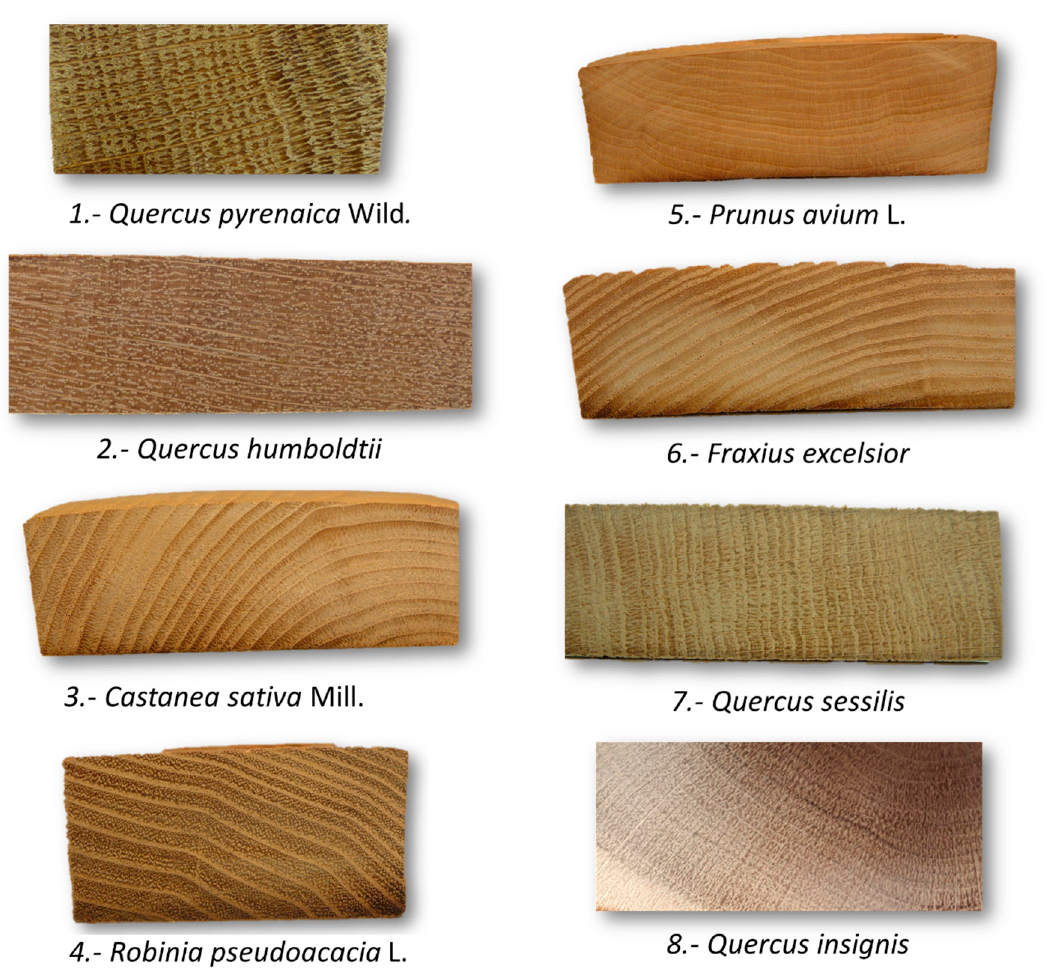
Figure 1. Cross-sections of some of the non-standard species in cooperage in comparison with Q. sessilis .